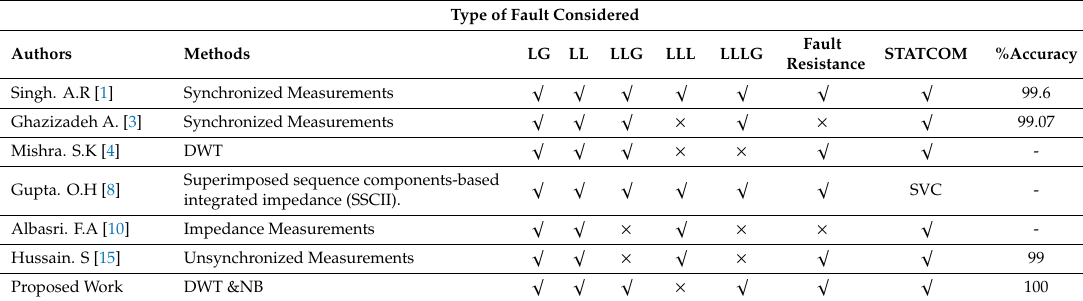
Table 11. Performance comparison with literature work.